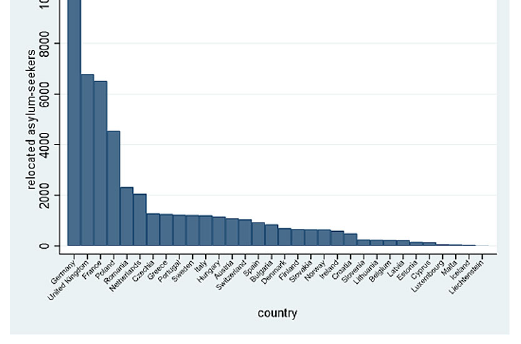
Figure 4: Number of asylum seekers the 32 European and associ- ated countries are required to accommodate. Distribution was cal- culated based on population size and current death rates due to COVID-19. Countries with death rates below 20 per 100,000 re- ceive 12 asylum-seekers per 100,000 inhabitants; those with death rates between 20 and 35 per 100,000 receive 10 asylum-seekers per 100,000 inhabitants and countries with death rates above 35 per 100 000 receive 2 asylum-seekers per 100,000 inhabitants. Graph adapted from the open letter to the European Parliament ([9], https://www.evacuate-moria.com/) with permission from Prof. Bozorgmehr. Mortality rates and population sizes were extracted from Eurostat on 16 April 2020. Tableau Publique. COVID19 Trend Tracker. 2020. https://pub-